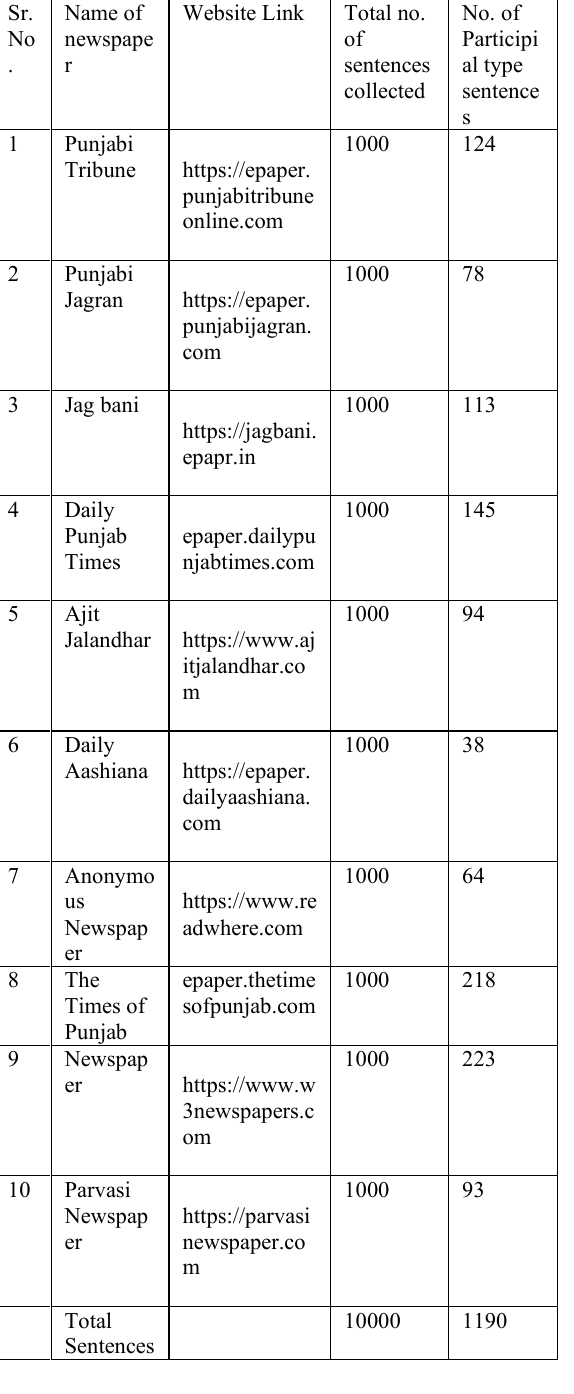
Table 4: Corpus collected from online sources (e-papers) Sr.